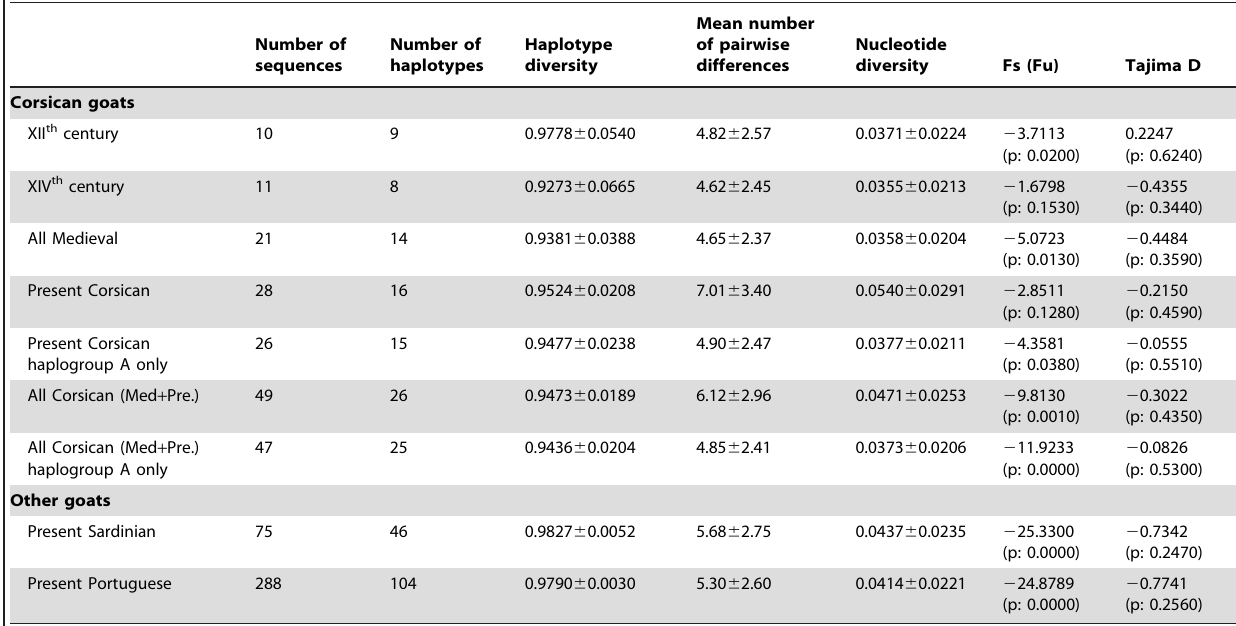
Table 1. Genetic diversity